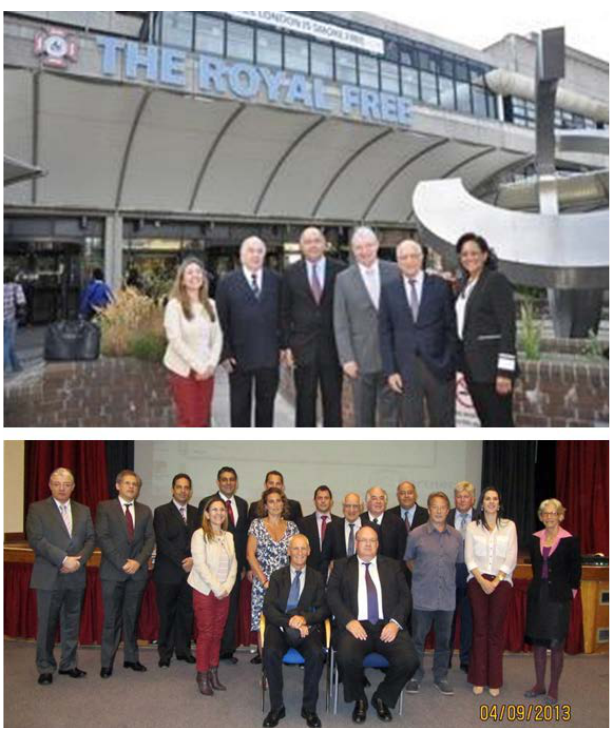
Fig. 6 - The 2 nd Anglo/Brazilian meeting. Royal Free Hospital, Hampstead, London. Top panel (left to right): Professors Tania Maria de Andrade de Rodriques, Otoni Moreira Gomes, João Batista Vieira de Carvalho, Melchior Luis Lima, Elias Kallas, and Antoinette Oliveira Blackman at the main entrance of the Royal Free Hospital. Lower panel: Organisers and presenters at the 2 nd Anglo/Brazilian meeting, September 2013. (I am grateful to Melchior Lima for providing these